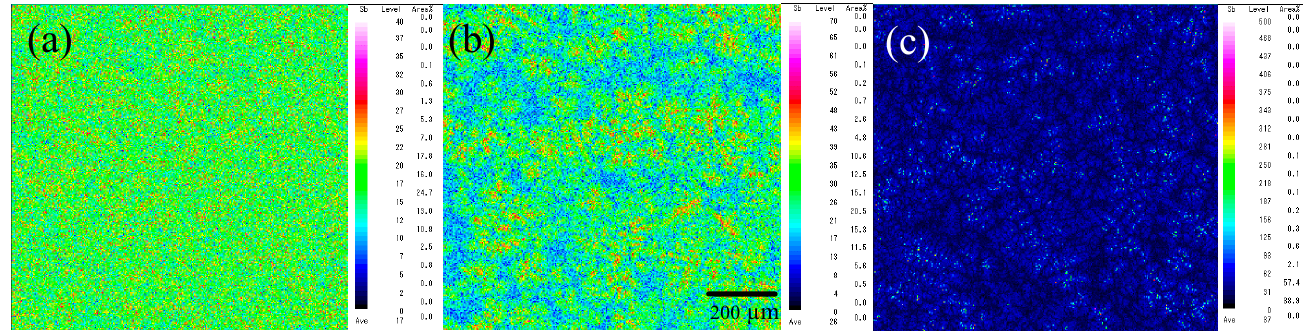
Figure 2. BSE images of ( a ) Sn-40Bi-0.1Sb, ( b ) Sn-40Bi-0.5Sb, and ( c ) Sn-40Bi-1.0Sb.